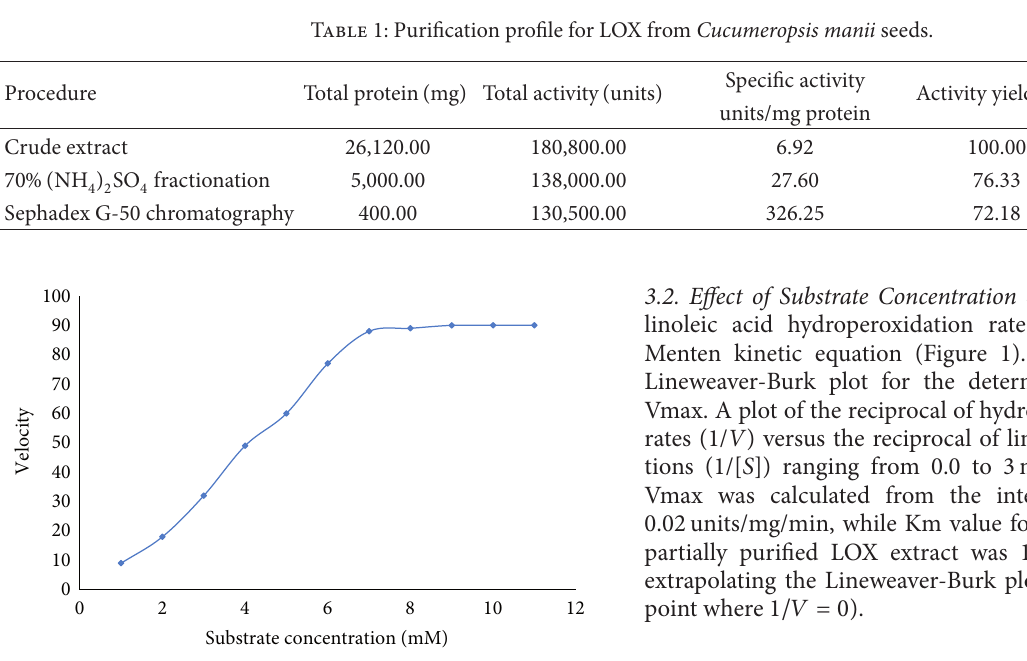
F 1: Michaelis-Menten plot showing the effect of substrate concentration on LOX.